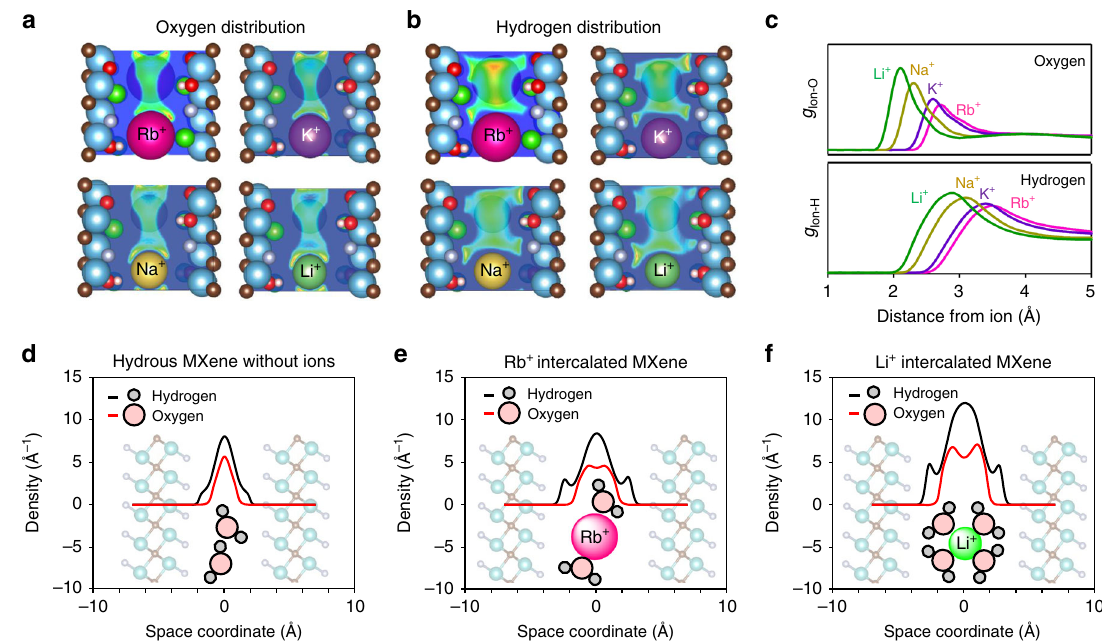
Fig. 2 3D-RISM calculation results for the hydrated ions con fi ned in the MXene microslit. a , b Oxygen and hydrogen distributions of ion intercalated Ti 2 CT x · n H 2 O. Ti (dark cyan), C (brown), O (red), F (gray), Cl (green), and H (pale pink) atoms are shown. c Radial distribution functions of ion – oxygen and ion – hydrogen distances. d , e , f Hydrogen and oxygen atomic density pro fi les along the c axis (perpendicular to the MXene layers) in hydrous, Rb + intercalated, and Li + intercalated Ti 2 CT x · n H 2 O. The optimized n values are 0.5, 0.8, and 1.35 for the hydrous, Rb + intercalated, and Li + intercalated MXenes, respectively, and these values are consistent with the thermogravimetric experimental results (Supplementary Fig.